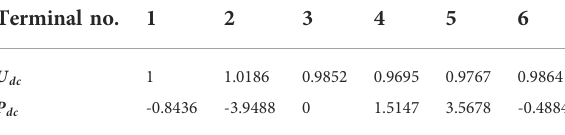
TABLE 6 Numerical solution from power fl ow analysis (in P.U.).